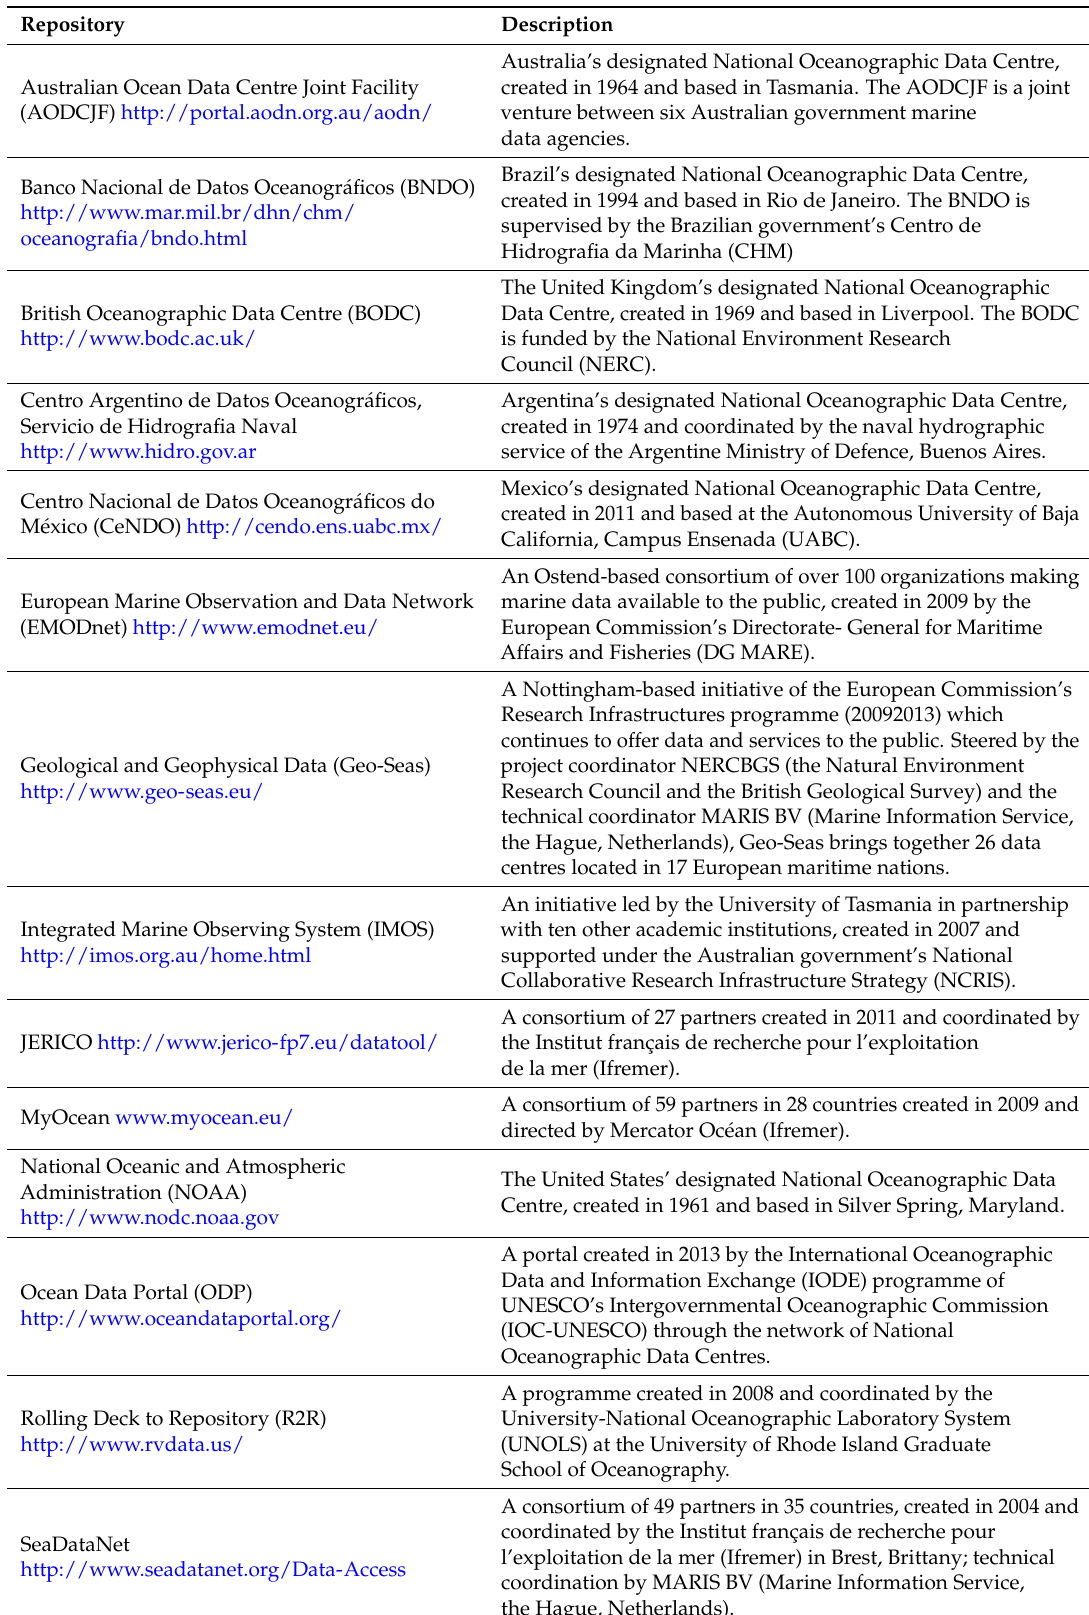
Table 1. Oceanographic data